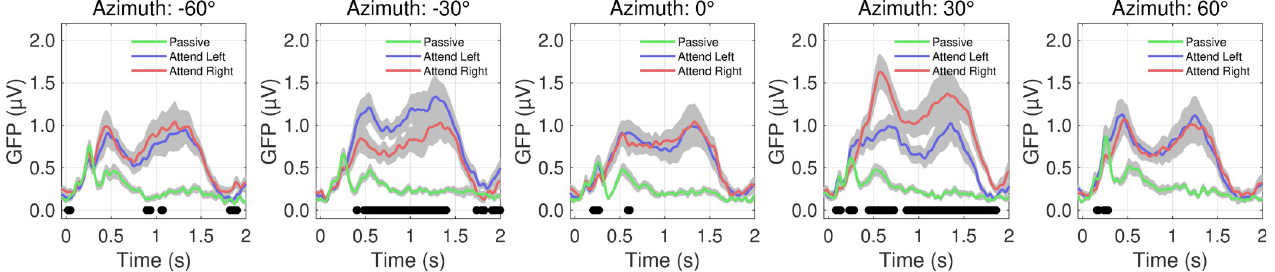
Fig 3. Grand average global field power (GFP) for stimuli presented in quiet background for each attention condition (Passive [green]; Attend Left [blue]; Attend Right [red]). The five panels represent trials in which the target arrived at each of the five horizontal speaker locations (from left to right: -60˚ to +60˚). Grey shaded regions represent standard error of the mean, and black horizontal markers represent time latencies in which a significant difference was found between Attend Left and Attend Right conditions in a paired-sample t-test (alpha = 0.5; n = 18).